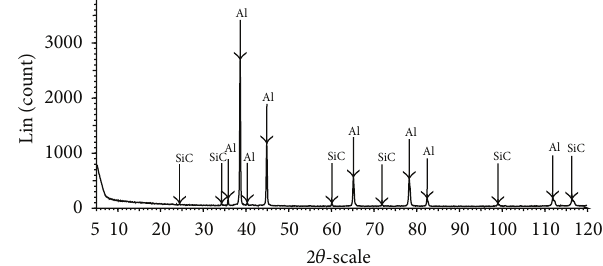
Figure 5: X-ray diffraction patterns of 6061 Al/SiC powdered